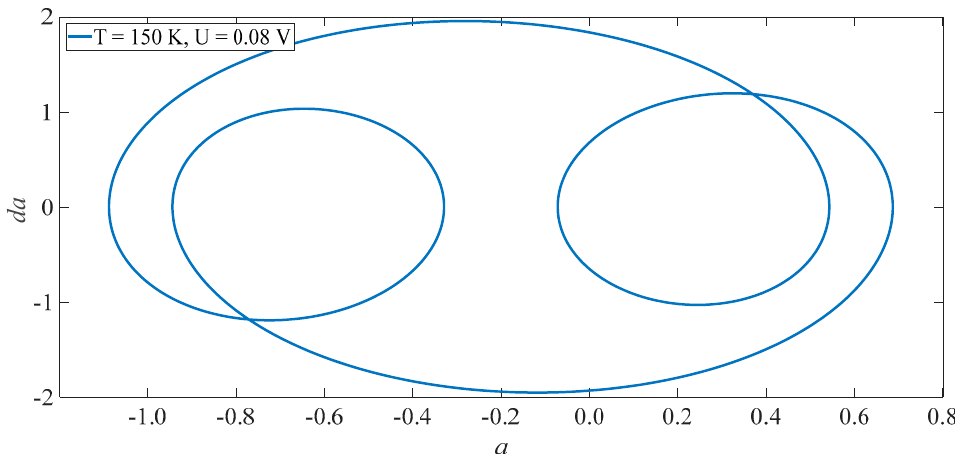
Figure 16. Phase diagram of the first mode with ( c 1 , f 1 , σ ) = ( 5, 3.5, 80 ) .